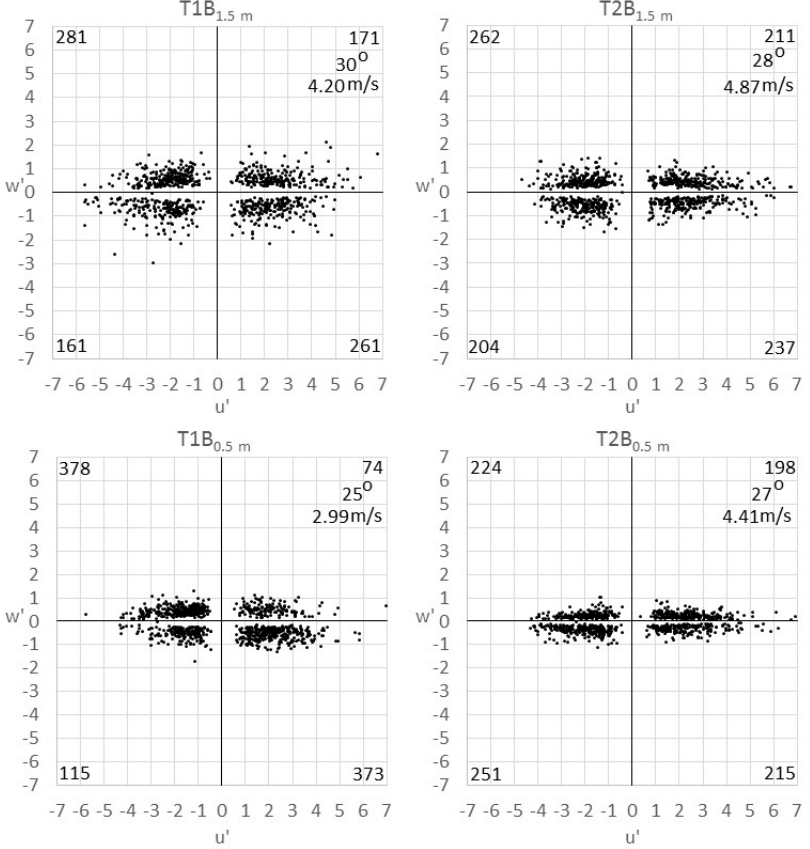
Figure 12. Beach (T1B and T2B) Quadrant plots (1 Hz) for all runs (80 min, n = 4800). Each plot includes data from all eight runs to better visualize the gross distribution of RS Hk components in the quadrant plots. However, only those fluctuations deemed to be significant (>1 standard deviation) are shown in the plots (total number in each quadrant is indicated by the values in the corners). The top right-hand corner also displays the mean incident flow angle (0° is alongshore, 90° is onshore), and wind speed (S) for all eight runs.